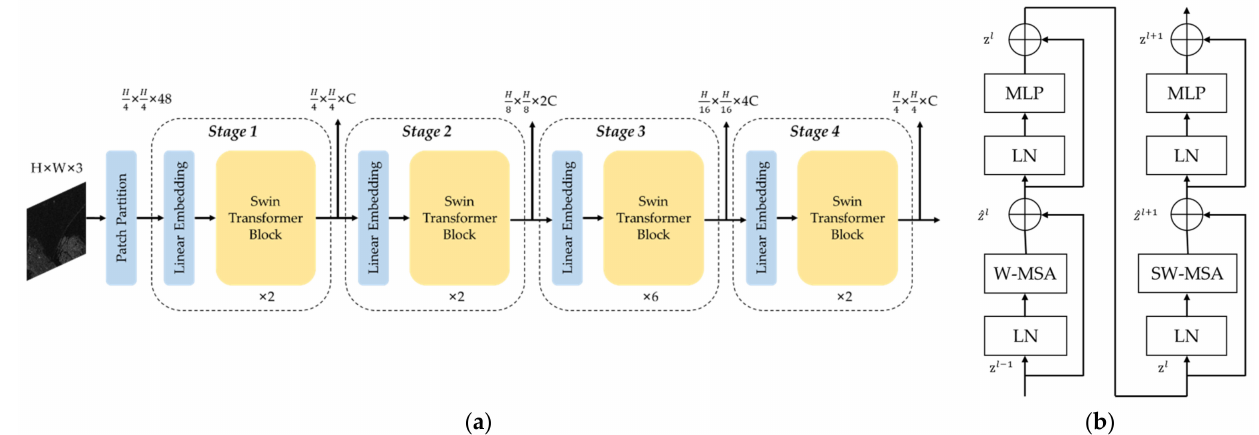
Figure 2. Architecture of the Swin Transformer. ( a ) Swin Transformer structure; ( b ) Swin Transformer block structure.